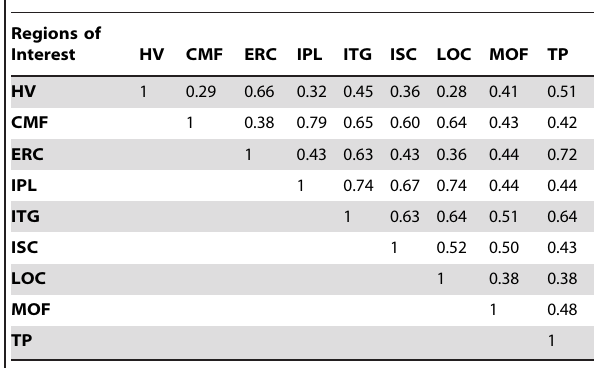
as well as p-tau positive from p-tau negative CN individuals. In all of the analyses performed, age, gender, education, and APOE- e 4 carrier status were additionally included.